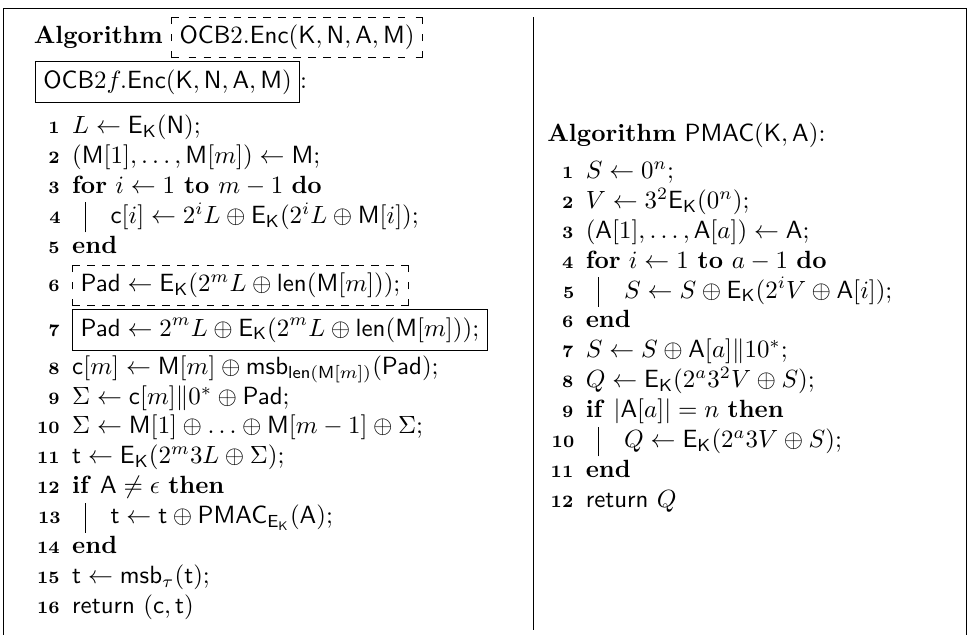
Algorithm OCB 2 . Enc ( K , N , A , M )